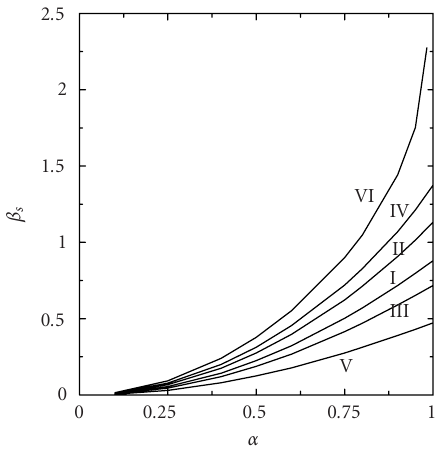
Figure 3.7. Comparison of the variation of the smaller root β s of (3.10) for both unstaggered ( λ = 1) and staggered ( λ = − 1) stationary localized states as a function of the parameter α for various values of the nonintegrability parameter ν . Curve I: ν λ = − 0 . 1, curve II: ν λ = 0 . 1, curve III: ν λ = − 0 . 25, curve IV: ν λ = 0 . 25, curve V: ν λ = − 0 . 5, and curve VI: ν λ = 0 .